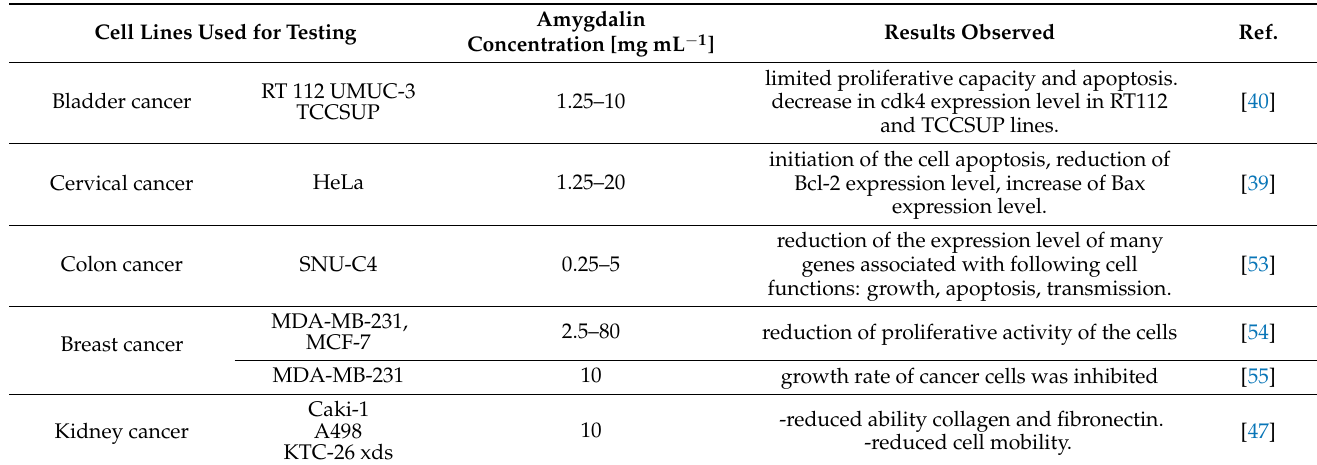
Table 4. Examples of in vitro cytotoxicity studies on cancer